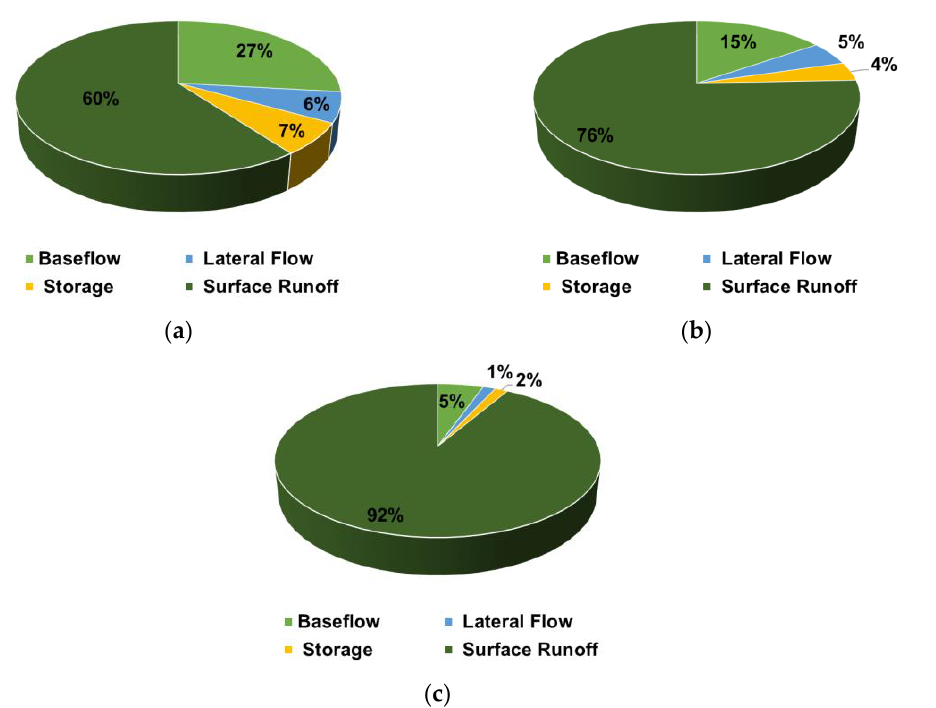
Figure 6. Distribution of water yield elements in forest patches ( a ), mature oil palm ( b ), and young oil palm ( c ).